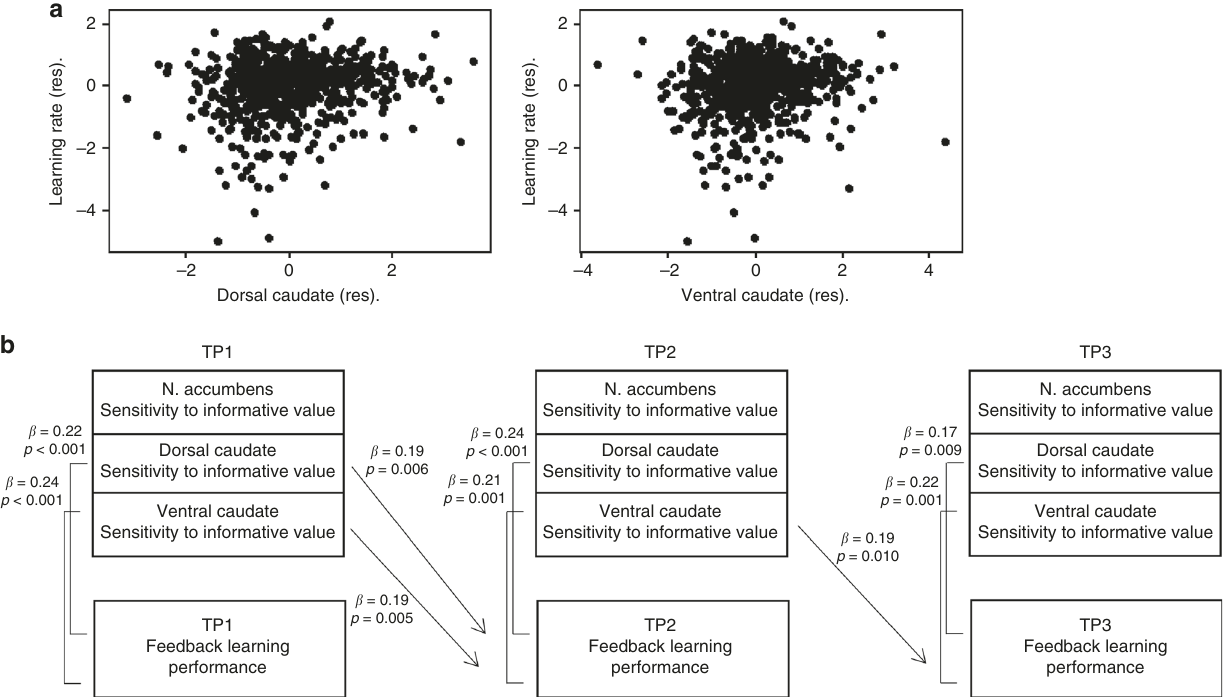
Fig. 3 The relation between striatal activity and learning performance. a Scatterplot of the relation between learning performance and sensitivity to informative value in dorsal caudate ( B = 0.51, p = 0.002) and ventral caudate ( B = 0.44, p = 0.007) ( N = 731). The regression residuals for learning performance predicted by age 2 and dorsal/ventral caudate predicted by age 2 are plotted. b Schematic overview of the cross-sectional and longitudinal regression analyses demonstrating that sensitivity to informative value in dorsal and ventral striatum activity predicts learning performance at the same time point. Activity in dorsal and ventral caudate predicts learning performance 2 years